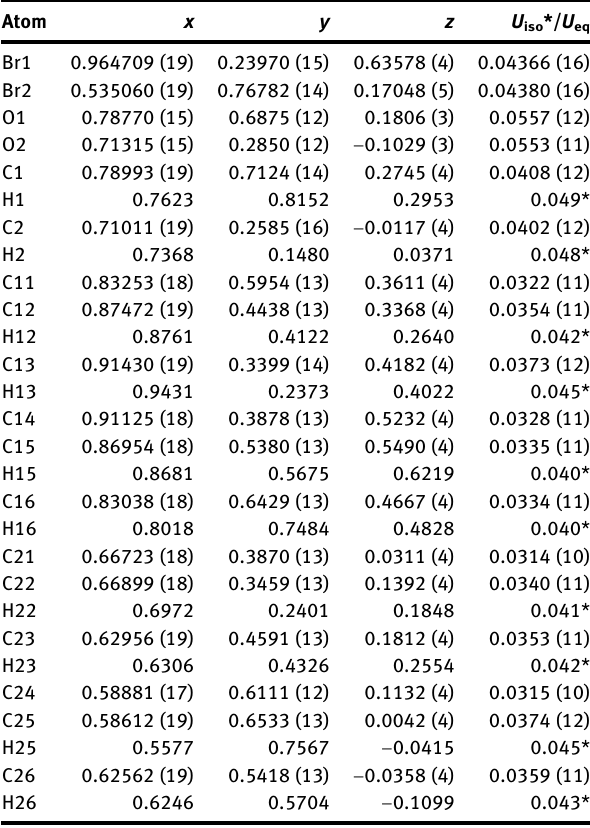
Table  : Fractional atomic coordinates and isotropic or equivalent isotropic displacement parameters (Å 